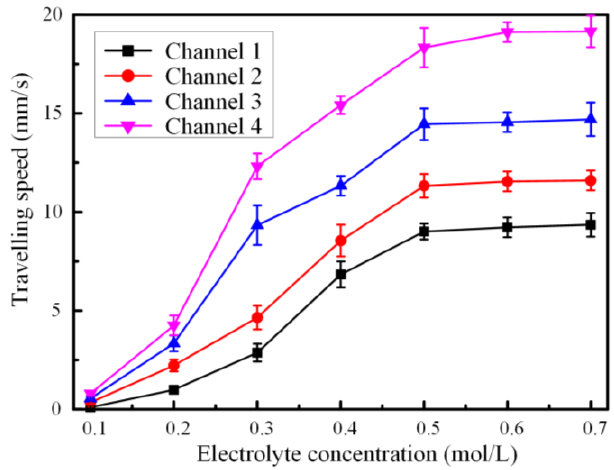
Figure 3. Plot of actuation speed of liquid metal slug with respect to the electrolyte concentration at a 150 Hz 4 Vpp sinusoidal wave with a 4 V DC o ff